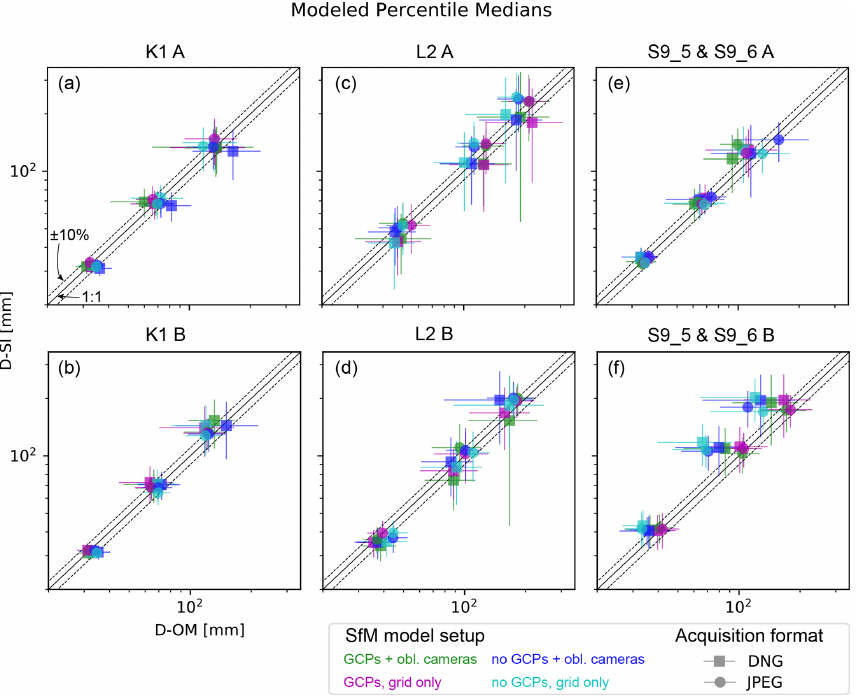
Figure 8. Modeled median values for percentiles D 50 , D 84 , and D 96 from single images (SI) and orthophoto mosaics (OM) for selected regions of the survey sites. Different SfM model setups are color-coded; please see Fig. 2 for detailed legend. Displayed uncertainties represent modeled 95% confidence intervals. Please note the logarithmic